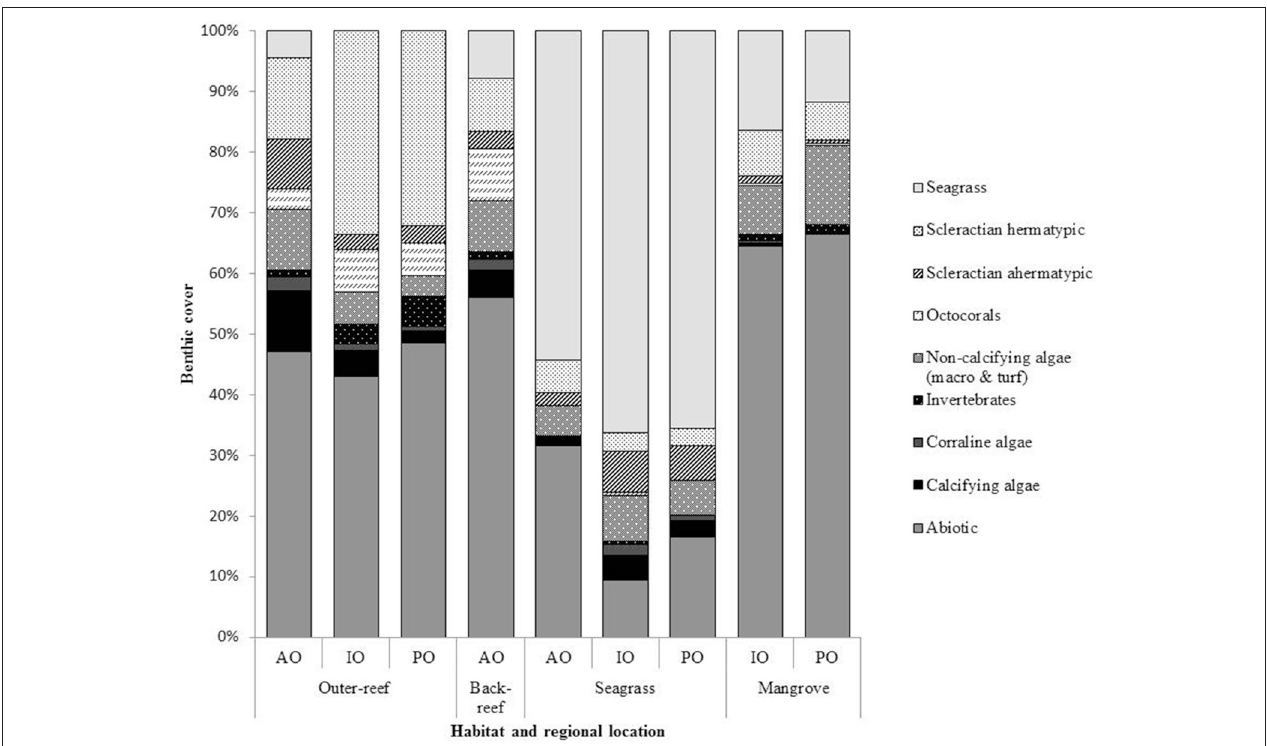
FIGURE 2 | The percentage cover of major benthic taxa at each habitat for the: Atlantic Ocean (AO), Indian Ocean (IO) and Pacific Ocean (PO) sites. Data is averaged from three by 30m transects conducted within each habitat at each bioregion location. Surveys were conducted in the dry season of each region between 2013 and